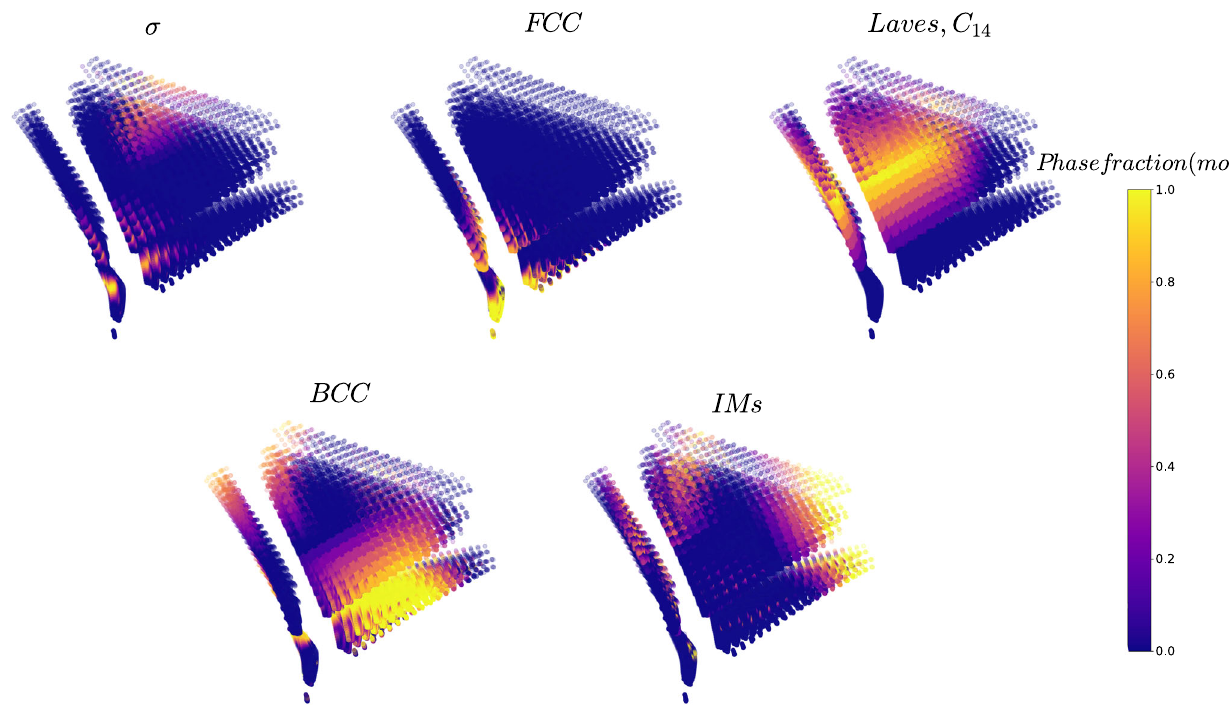
Fig. 2 Phase separation in PCA. Phase fraction heatmaps for the PCA transformation of the whole feature space in the training data set. Phases with higher concentration of an speci fi c phase/class cluster